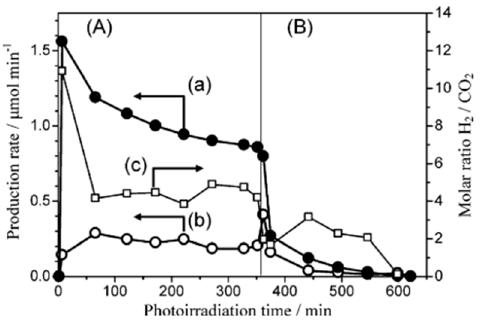
Figure 14. Production rates of (a) H 2 , (b) CO 2 , and a molar ratio of (c) H 2 /CO 2 , where the input gas was ( A ) CH 4 (50%) + H 2 O (1.6%) and ( B ) H 2 O (1.6%). Reprinted with permission from [40]. Copyright (2008), American Chemical Society.